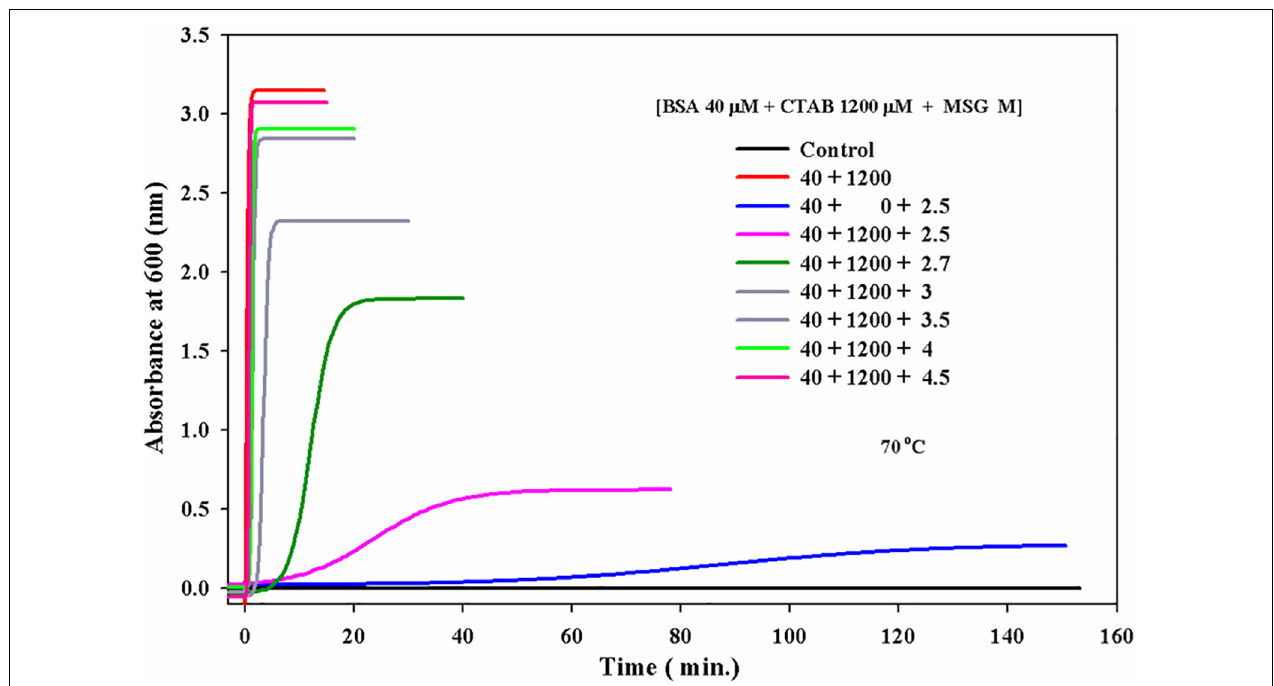
FIGURE 5 | Effect of monosodium glutamate on the kinetics of CTAB-induced aggregation of BSA at 70 ◦ C temperature 25 mM phosphate buffer, pH 7.0 and wavelength of 600 nm.